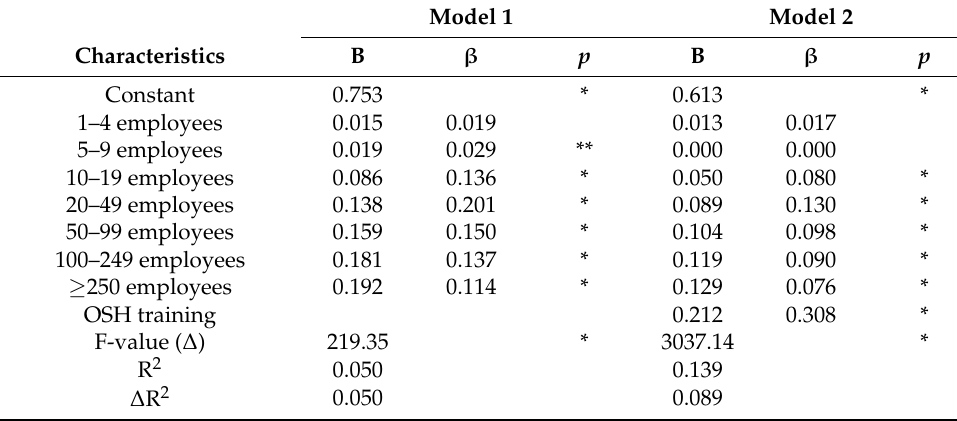
Table 4. Linear regression with compliance index as a dependent variable. Including unstandardized (B) and standardized ( β ) regression coefficients.